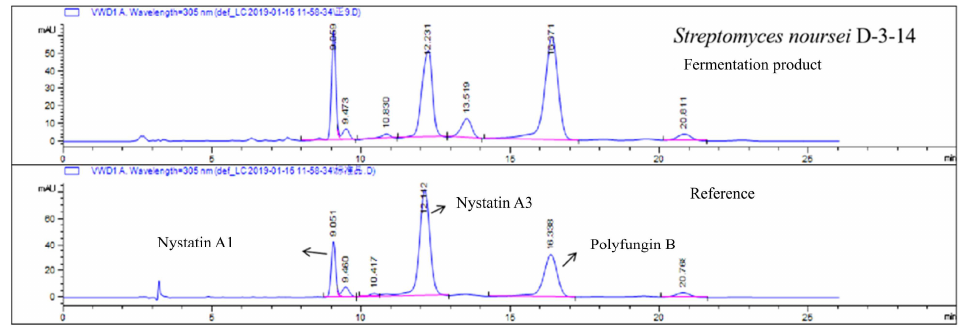
Figure 2. HPLC analysis of the fermentation products of Streptomyces noursei D-3-14 and the refer- ence.